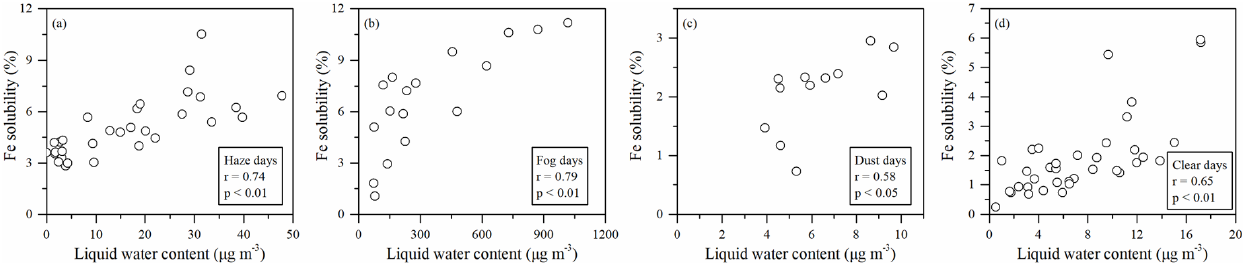
Figure 7. Correlations between Fe solubility and liquid water content on haze (a) , fog (b) , dust (c) , and clear (d)